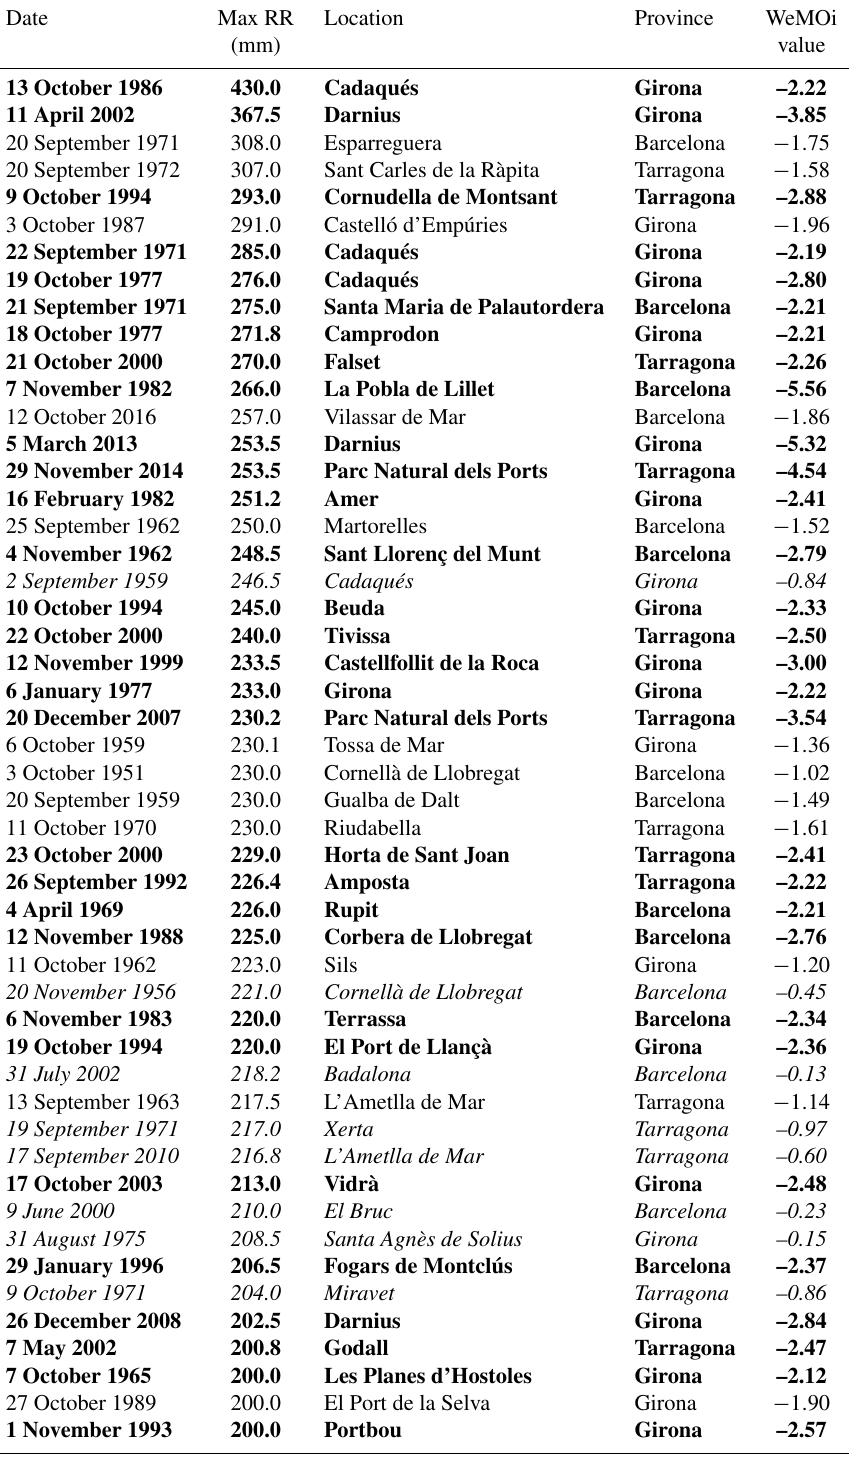
Table 1. Catalogue of extreme torrential events ( ≥ 200mm in 24h, 07:00–07:00UTC) in Catalonia (NE Iberia) during the 1951–2016 period. Max RR is the highest precipitation accumulation of the episode. The events are classified according to the extreme negative Western Mediterranean Oscillation (WeMO) phase (bold), the negative WeMO phase and the slight negative WeMO phase